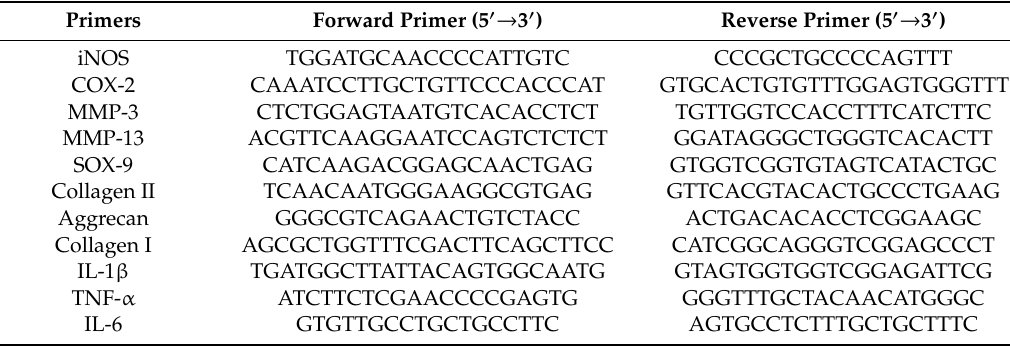
Table 1. Sequences of the primers used for